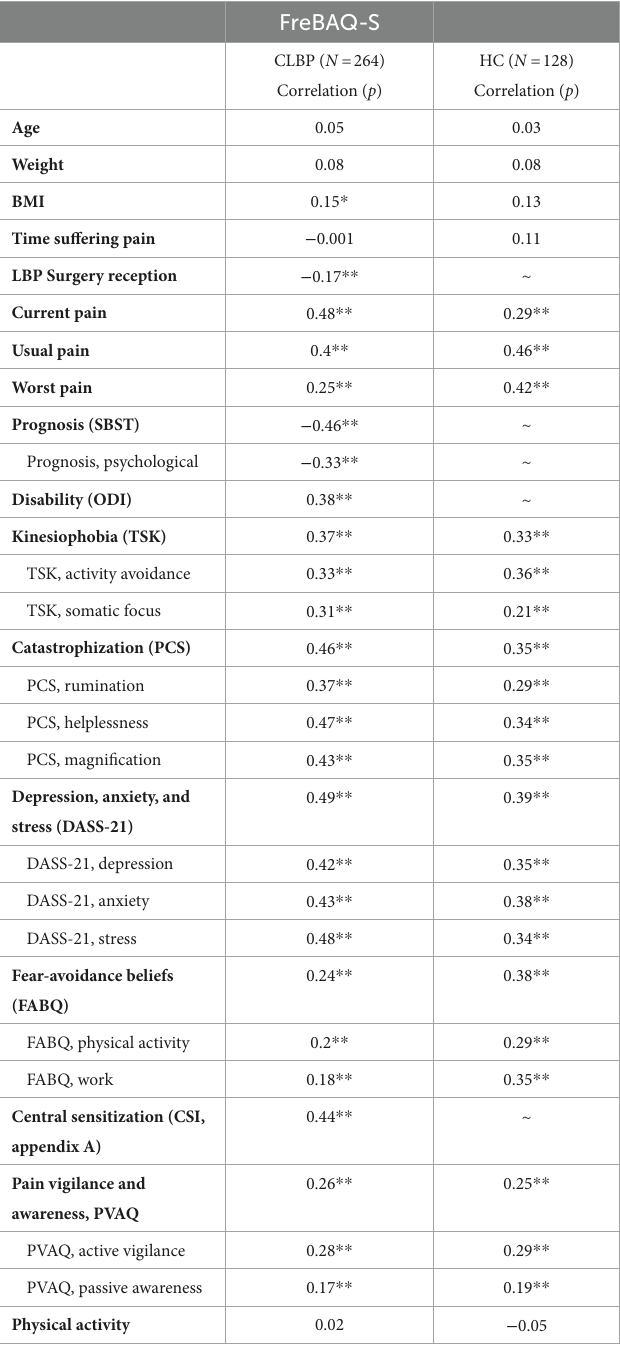
TABLE 4 Correlation analysis between FreBAQ-S scores and standardized variables related to pain experience in the CLBP and HC sample.